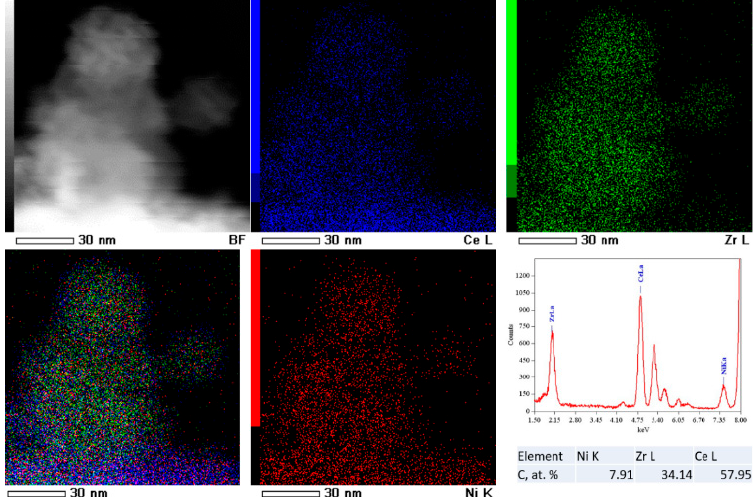
Figure 9. HAADF and STEM-EDX elemental mapping images of Ni-Ce 0.7 Zr 0.3 op.